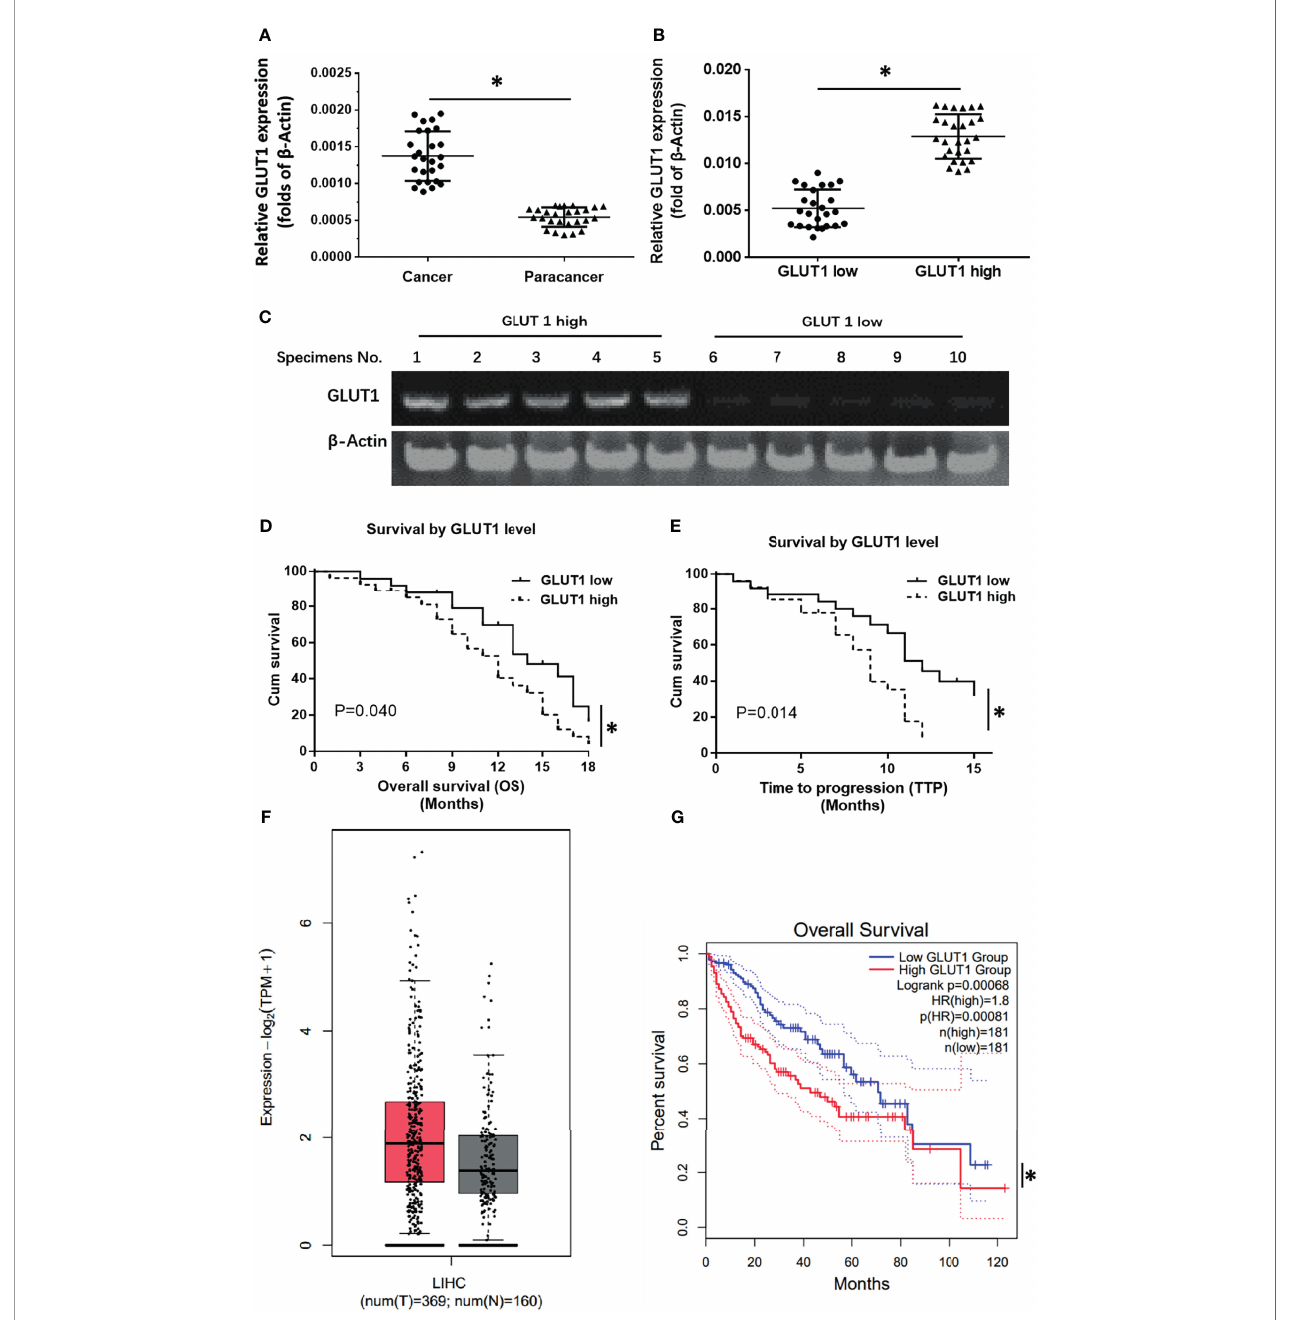
FIGURE 1 | The clinical signi fi cance of GLUT1 in advanced HCC. (A) The endogenous expression of GLUT1 in HCC or the para-tumor non-tumor tissues was examined by qPCR and shown as scatter-plot images. (B) The endogenous expression of GLUT1 in HCC tissues was examined by qPCR and is shown as the scatter-plot images. (C) The patients were divided into two groups (the GLUT1 high expression group and the GLUT1 low expression group) and the representative GLUT1 DNA electropherograms are shown. (D, E) Survival outcomes (OS and TTP) of the two patient groups. (F) the GLUT1 expression in a larger cohort of HCC patients from database (the HCC and non-tumor tissues); The left group of the scatter-plot indicated the HCC groups (T, tumor) (F) and the right group of the scatter-plot indicated the paired non-tumor groups (N, non-tumor) (F) . (G) the prognosis of patients with high GLUT1 or low GLUT1 in a larger cohort of HCC patients from database. *P<0.05. LIHC, liver hepatocellular